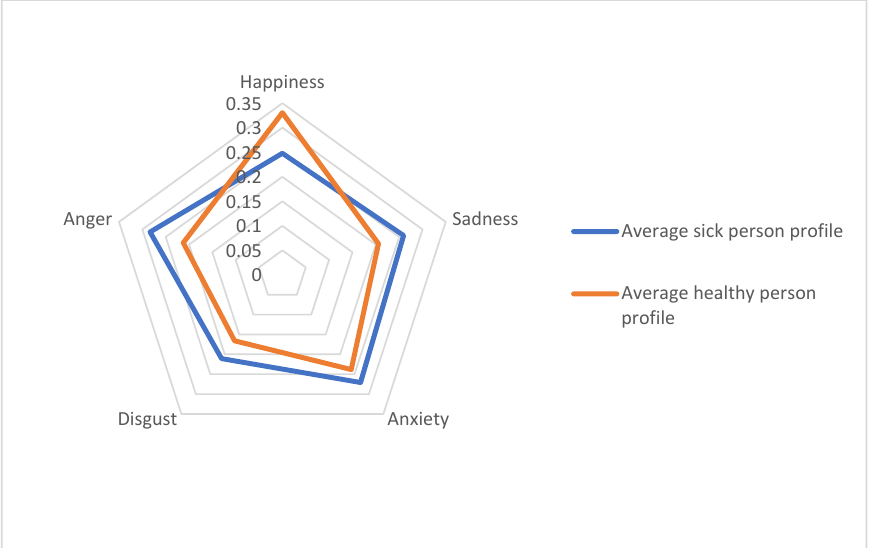
Figure 3. Profiles of a healthy and sick person after expanding operation (the values of the intensity of emotions range from 0 to 1, where 0 means that there is no emotion in the note, and 1 the maximum value of emotion in the